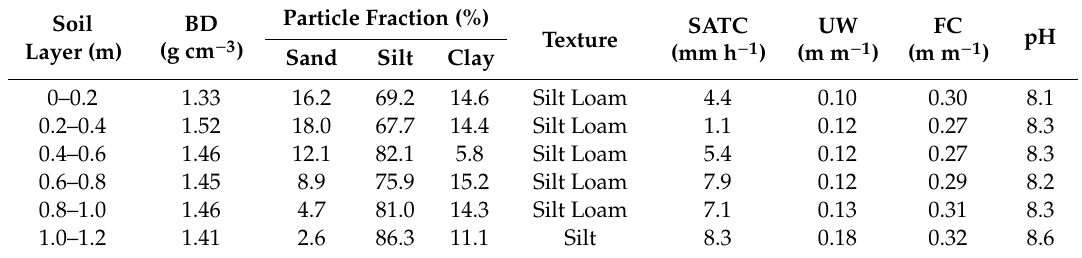
Table 1. Soil texture and hydraulic properties of the soil profile at the Wuqiao experimental site.